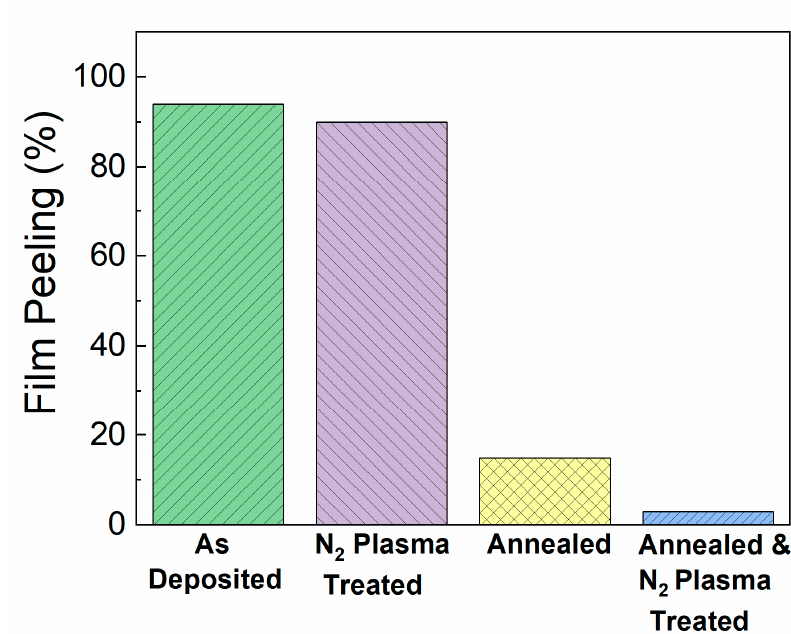
Figure 6. Summary of how N 2 plasma treatment and post-deposition annealing a ff ect delamination and bubbling of SiC-coated fluorapatite glass-ceramics after immersion in a pH 10 bu ff er solution at 80 ◦ C for 30